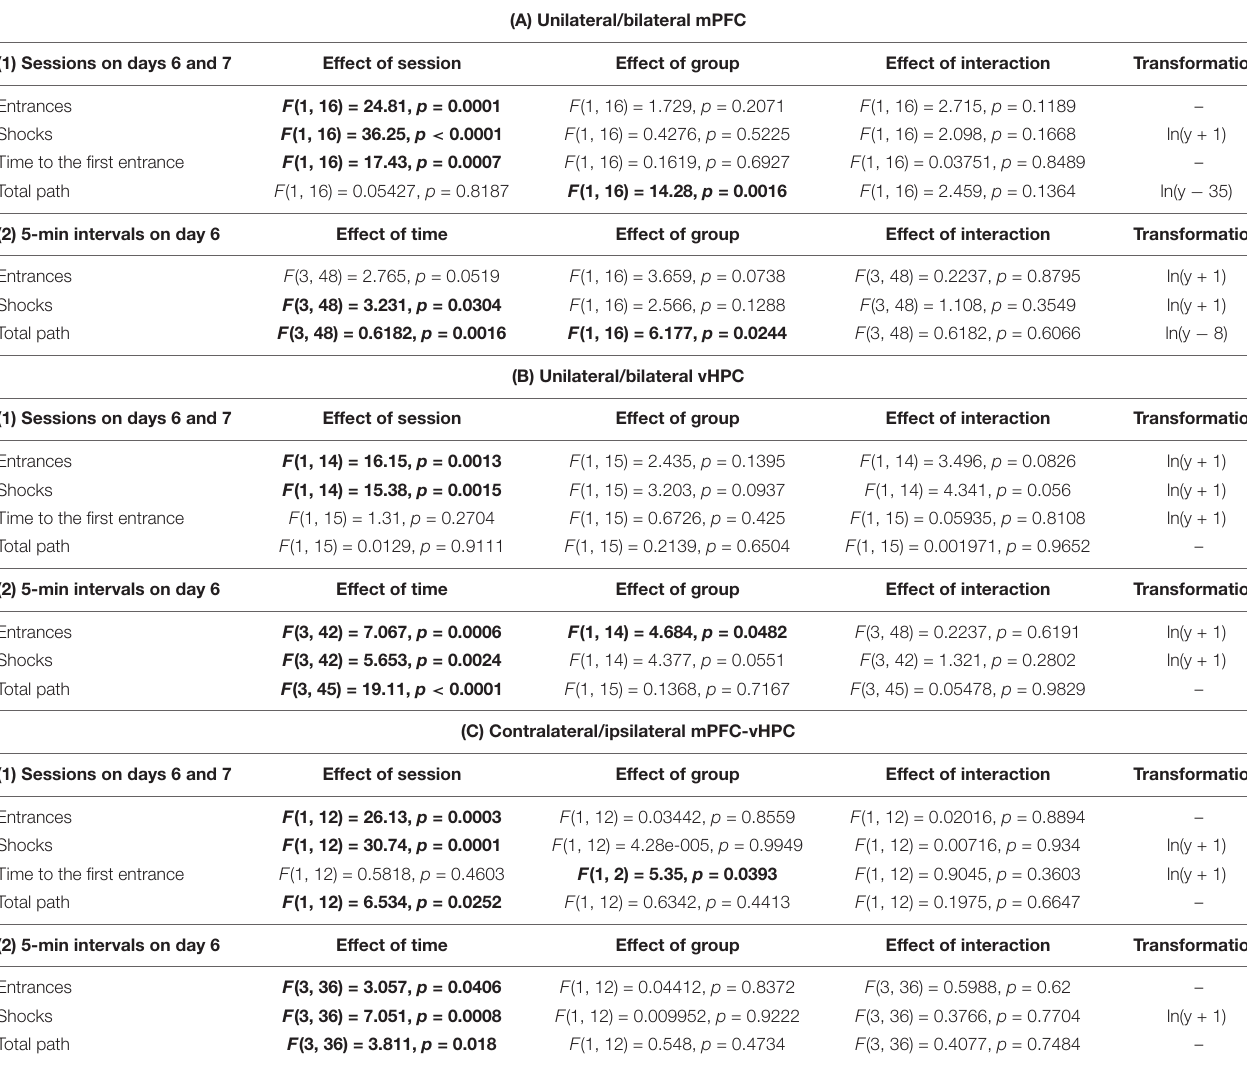
TABLE 1 | Summary of two-way ANOVA results between the experimental groups on days 6 and